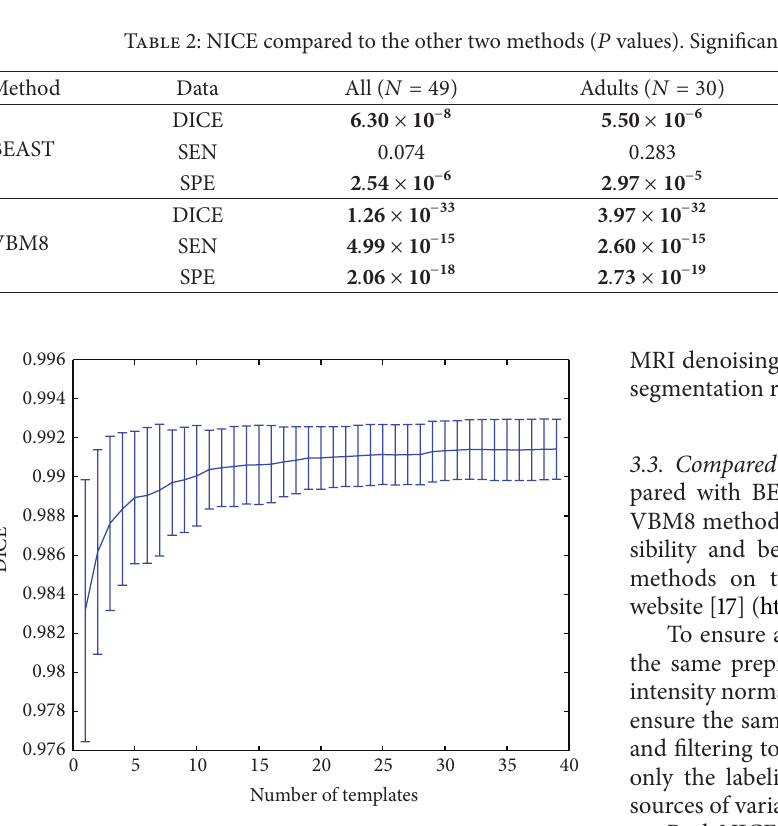
Figure 4: Evolution of segmentation accuracy in function of the number of training subject templates used in the segmentation